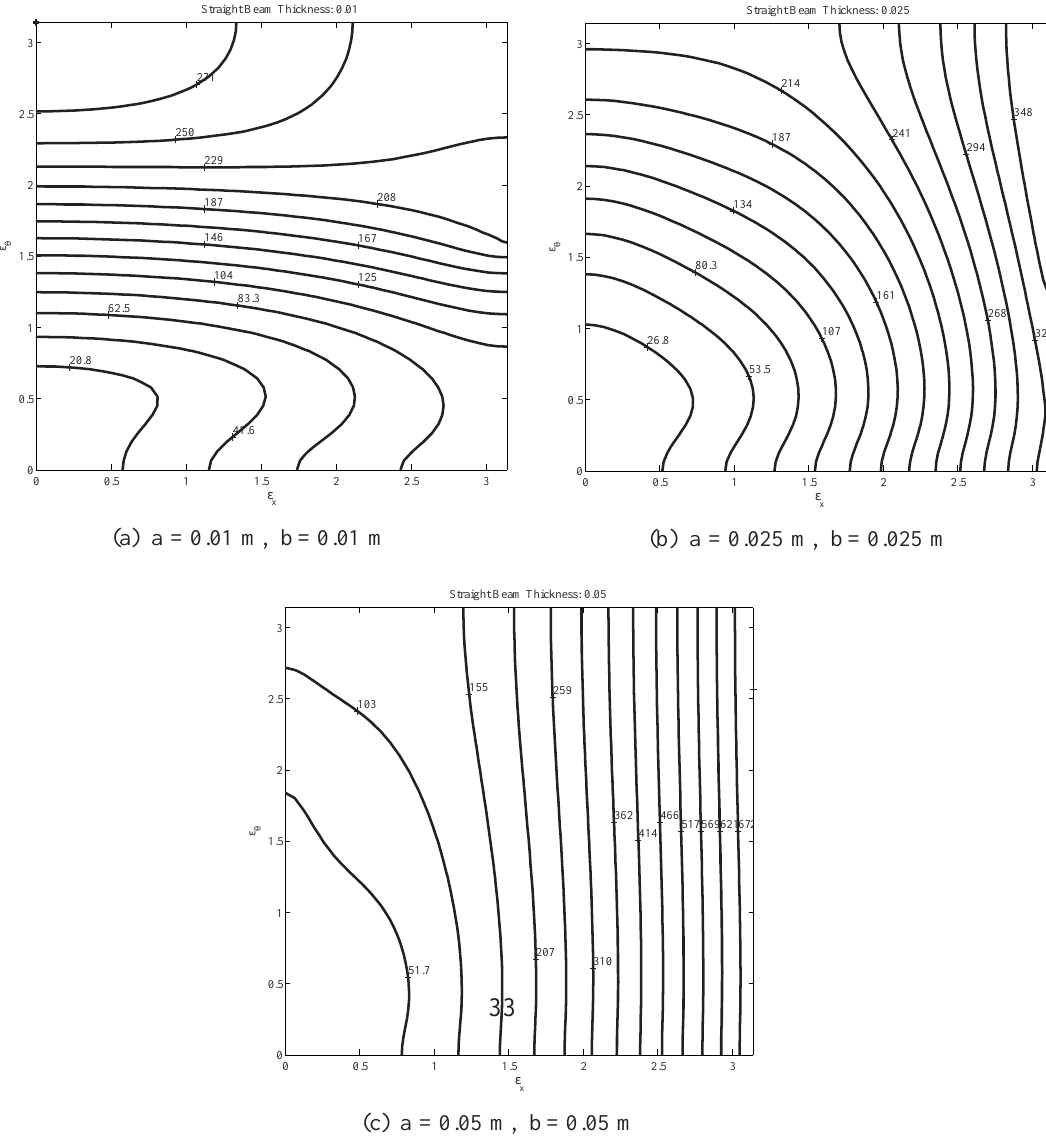
Fig. 8. Phase constant surfaces for rectangular